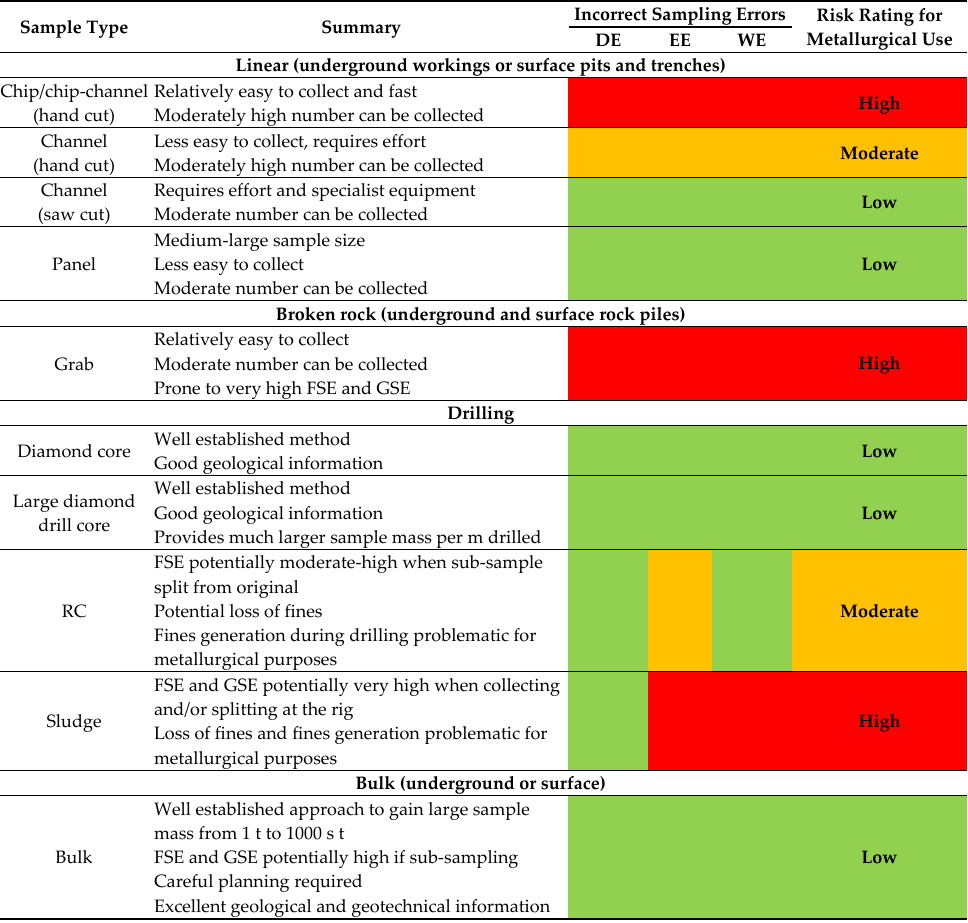
Table 13. Summary of sampling errors and related risk rating for different sample types. Errors are best case scenarios, based on optimised sample collection; Red: high; Orange: moderate; Green: low (modified from [37]).